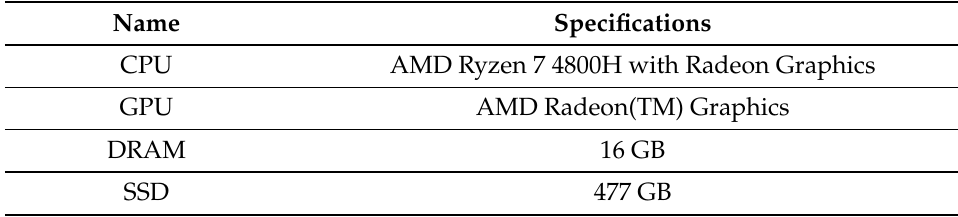
Table 4. Experimental environment configuration.